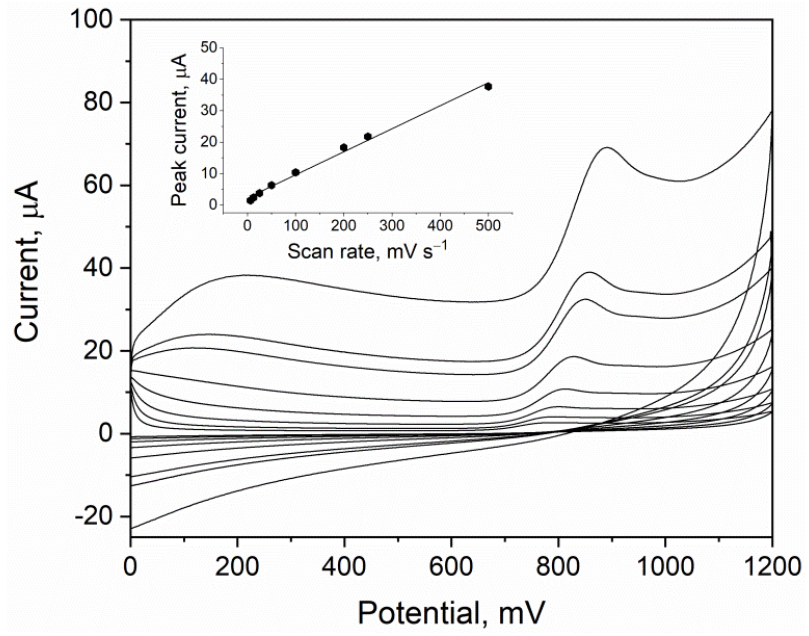
Figure 4. CV LSV measurement of 100 µM of CTZ in 0.1 M phosphate buffer. Scan rate values were in the range of 6.3 mV s − 1 to 500 mV s − 1 . Dependence of CTZ peak current on scan rate (inset).